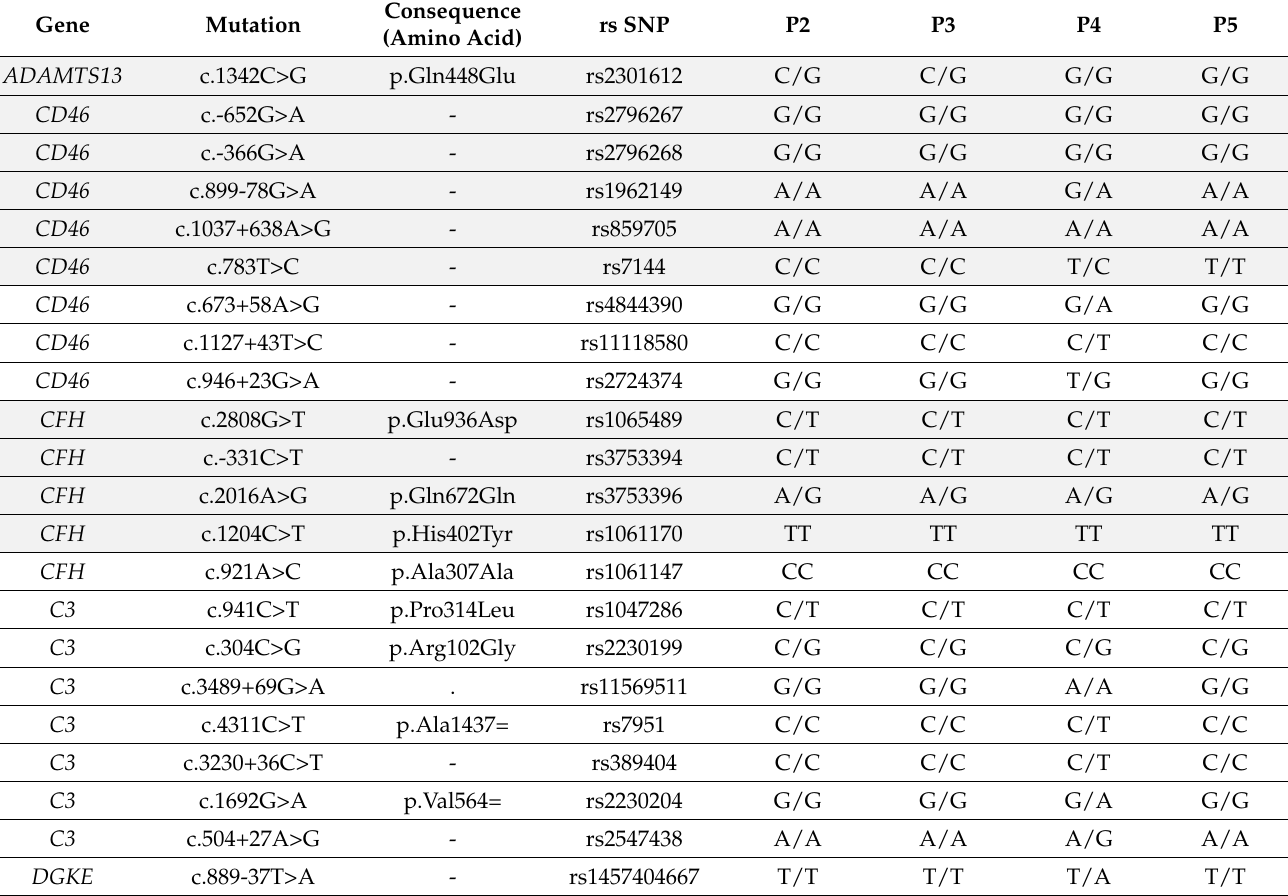
Table 1. Variants identified in the patients and described in the